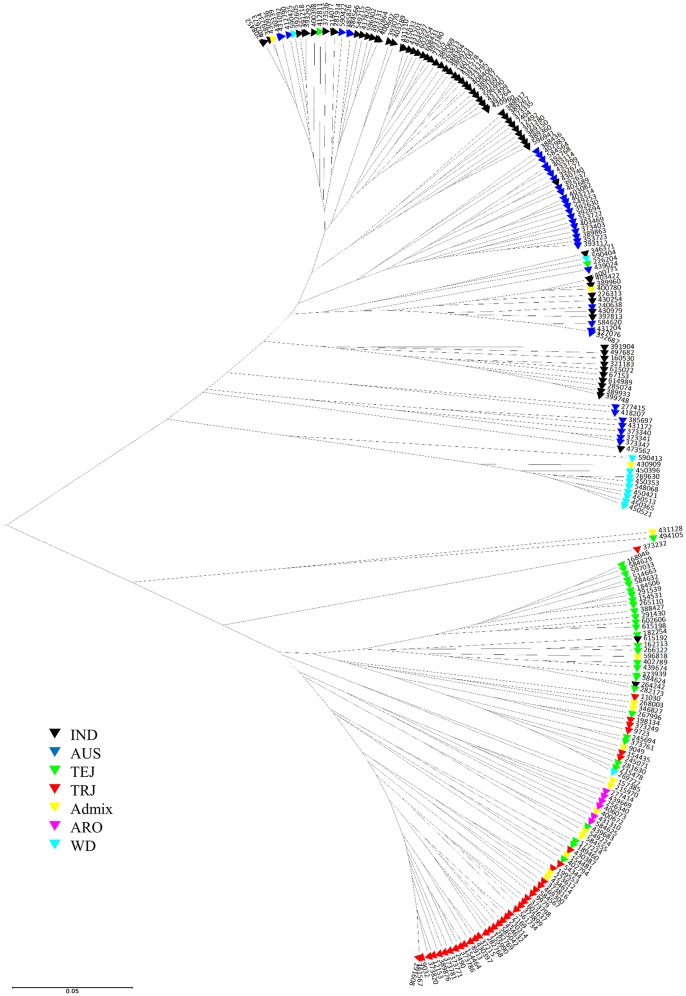
UPGMA tree of 217 access in USDA rice mini-core collection based on Nei's genetic distance calculated from 26 markers derived from 18 starch biosynthesis genes. The seven ancestry groups include IND indica, AUS aus, TEJ temperate japonica, TRJ tropical japonica, ARO aromatic, WD wild rice, and Admix accessions with mixed ancestry (classified according to Li et al., 2010).